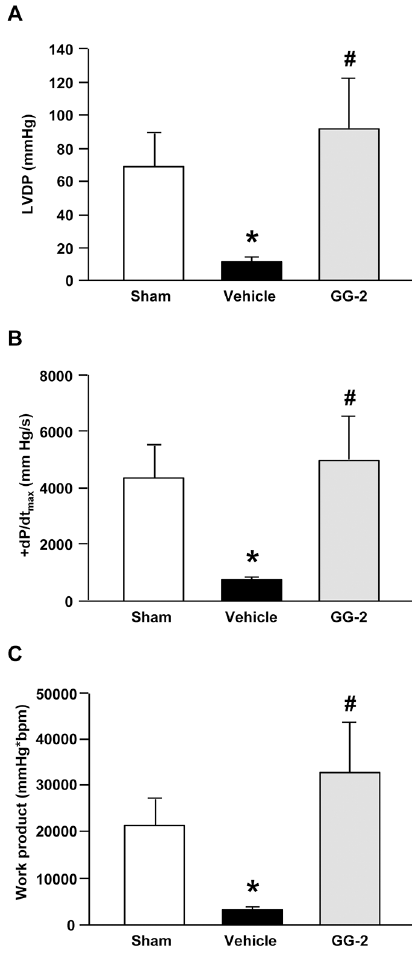
Figure 8. Effect of the combined treatment on cardiac contractile function in aged septic rats. Rats were sham operated or subjected to CLP with injection of vehicle (normal saline) or GG-2 (80 nmol/kg of ghrelin and 50 μ g/kg of GH) at 5 h after CLP. At 20 h after CLP, rats were anes- thetized, and left ventricular pressure measurements and heart rate were re- corded using a Millar pressure transducer. (A) LVDP, (B) maximal rate of ventricular pressure development (+dP/dt ) and max (C) work product were calculated. Data are expressed as mean ± SE (n = 5–7 per group). * P < 0.05 versus sham and # P < 0.05 versus